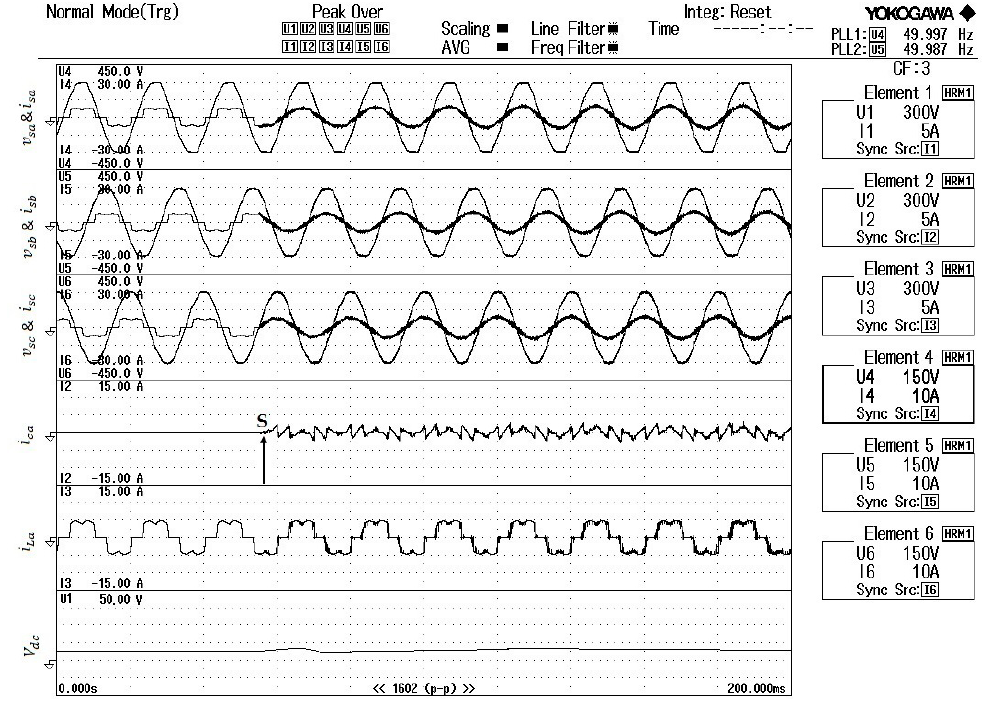
Figure 12. Hardware response of the compensator for current source type load.